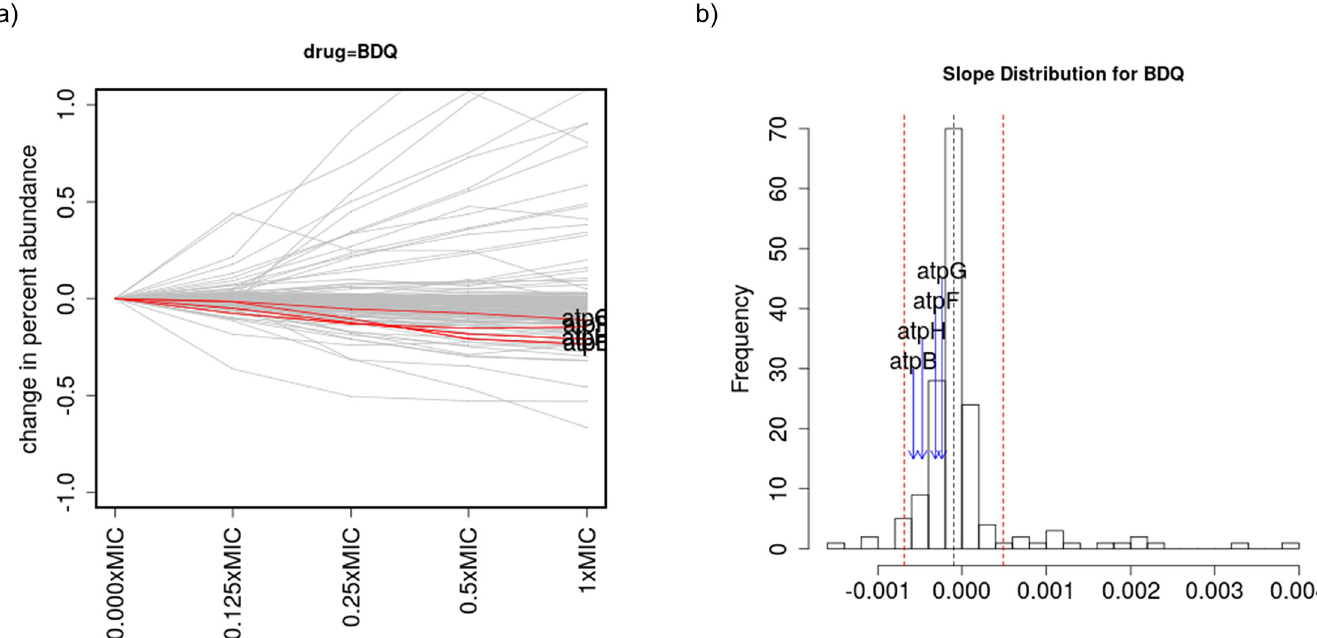
Fig 4. Analysis of chemical-genetic interactions with bedaquiline (BDQ). a) abundance plot for all genes in the hypomorph library, and b) histogram of the distribution of slopes for each gene. For bedaquiline, none of the 4 ATP synthase subunits in the library was detected as an outlier, but collectively, they all exhibited negative slopes, indicating depletion with increasing drug